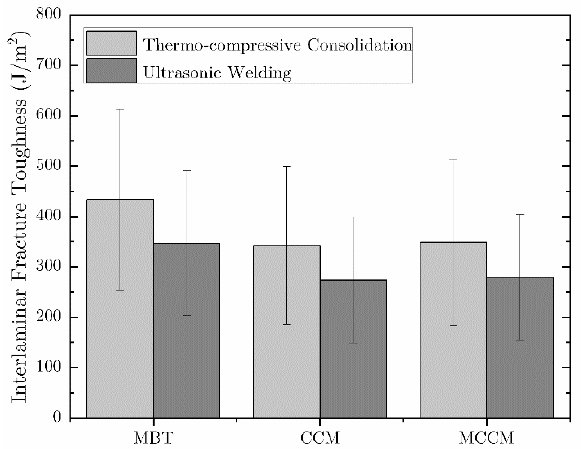
Figure 14. Mode-I interlaminar fracture toughness (J/m 2 ) plotted against the calculation method employed. Modified beam theory (MBT), compliance calibration method (CC), and modified compliance calibration method (MCC) were employed for the two sets of CFRPs tested (thermo-compressive consolidation and ultrasonic welding).